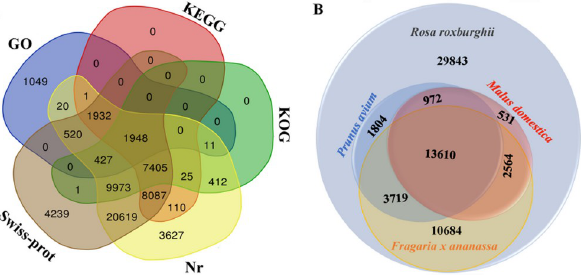
Fig 3. (A) Venn diagram of the number of unigenes annotated in five different databases. The number in the circles represents the number of unigenes annotated by single or multiple databases; (B) homology to strawberry ( Fragaria X ananassa ), apple ( Malus domestica ) and cherry ( Pruns avium